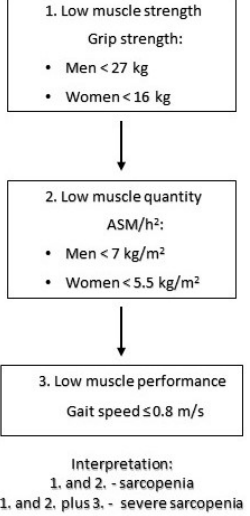
Figure 1. Sarcopenia diagnostic algorithm used in the study based on EWGSOP 2 recommendations [6].